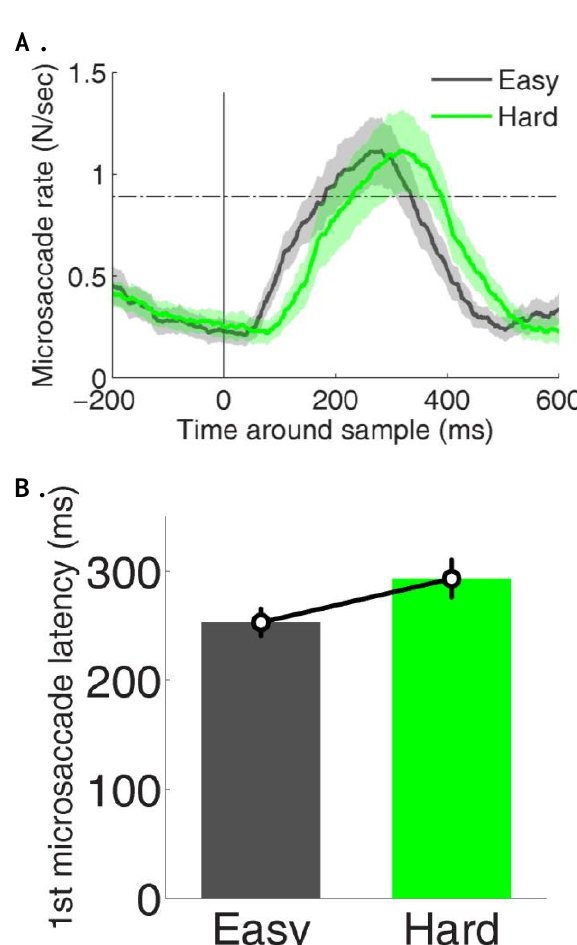
Figure 3. Timecourse of microsaccades during the easy and hard MTS tasks. (A) Microsaccade rates around MTS stimuli onset (gray vertical line). Horizontal line corre- sponds to the baseline. Shaded areas indicate S.E.M across subjects. (B) Average latency of the first microsaccade after each MTS stimuli onset. Error bars indicate S.E.M across